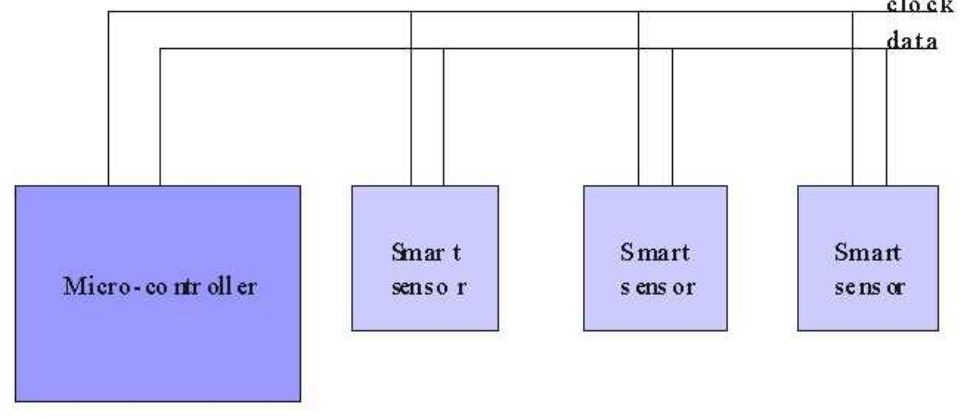
Figure 1 . Typical I 2 C bus